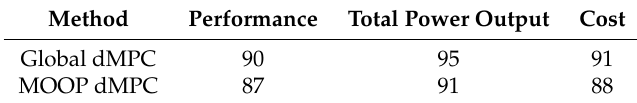
Table 2. Normalized units in percent for constant wind speed